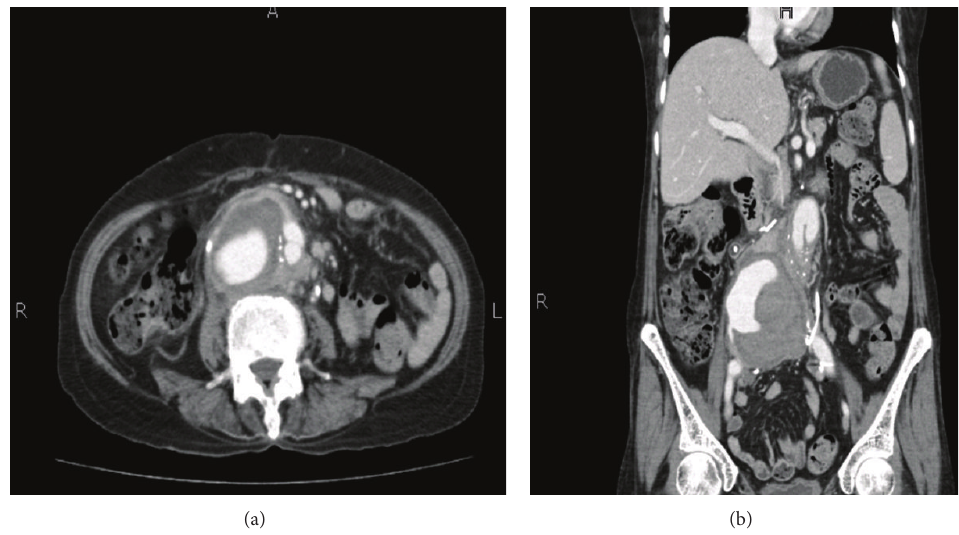
Figure1:A62-year-oldwomanwithpriorhistoryofsurgicalrepairofabdominalaorticaneurysmwithabifurcatedgraftpresentedwithdistal